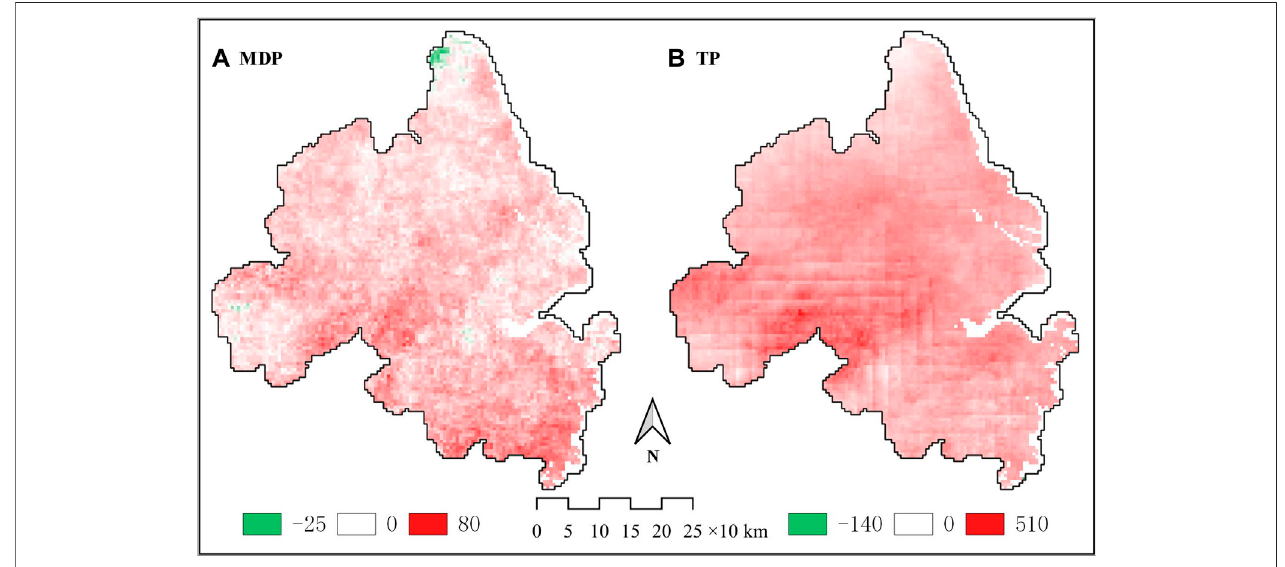
FIGURE 7 | The distribution of precipitation difference for 10-year period averages in the YDM between the 1990s and 2010s for (A) MDP and (B) TP.